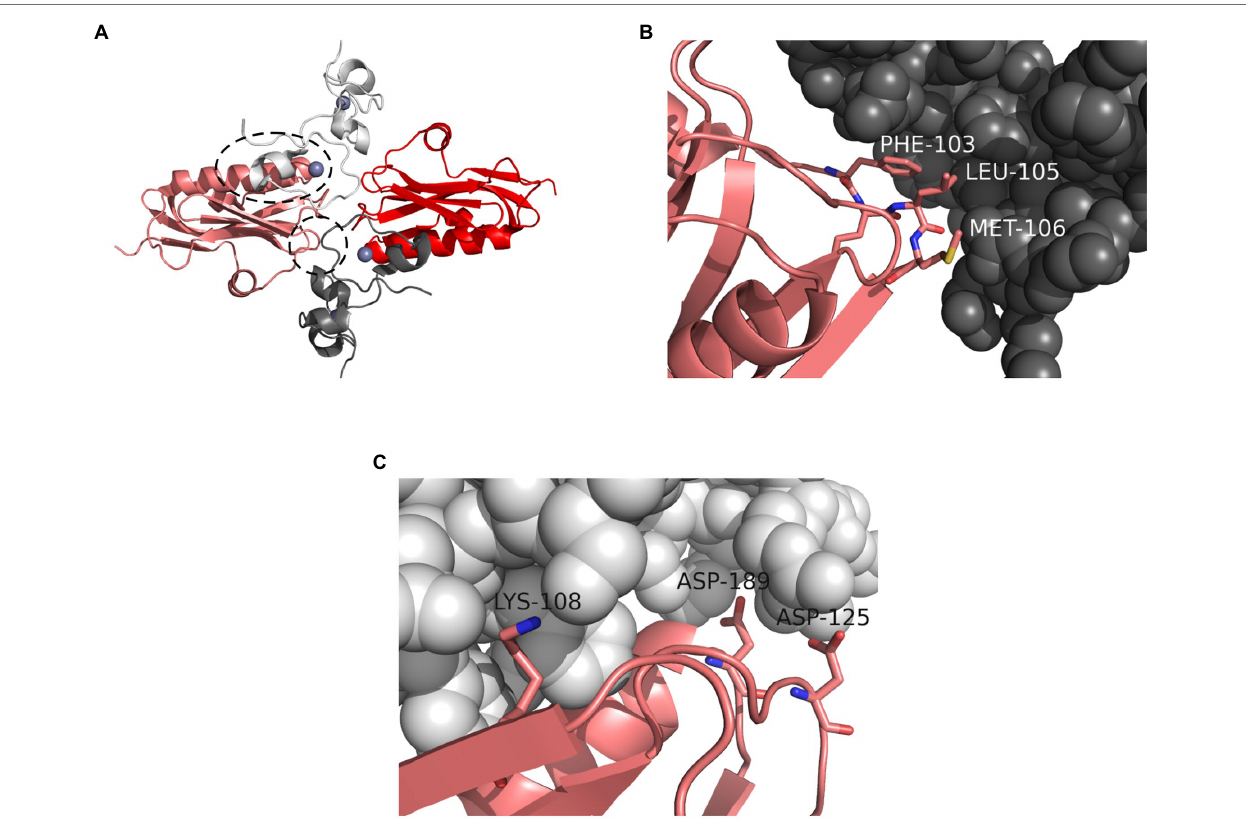
FIGURE 2 | Interaction between NS1 and CPSF4. (A) Crystal structure of two NS1 effector domains (red and pink) in complex with two fragments of human CPSF4, each comprising the second and third zinc fingers (white and dark gray). Zinc atoms are shown as blue spheres. The major interaction interface between the pink NS1 chain and the white CPSF4 chain is highlighted with a dashed oval. The minor interaction interface between the pink NS1 chain and the dark gray CPSF4 chain is highlighted with a dashed circle. The structure is symmetrical. (B) A view of the minor interaction interface between NS1 (pink) and CPSF4 (dark gray) showing the contributions of NS1 residues F103 and M106. (C) A view of the major interaction interface between NS1 (pink) and CPSF4 (white) showing the contributions of NS1 residues K108, D125, and D189. All three residues are making polar contacts with CPSF4 (not shown). Image was prepared with PyMol using the crystal structure from Das et al. (2008; PDB ID: